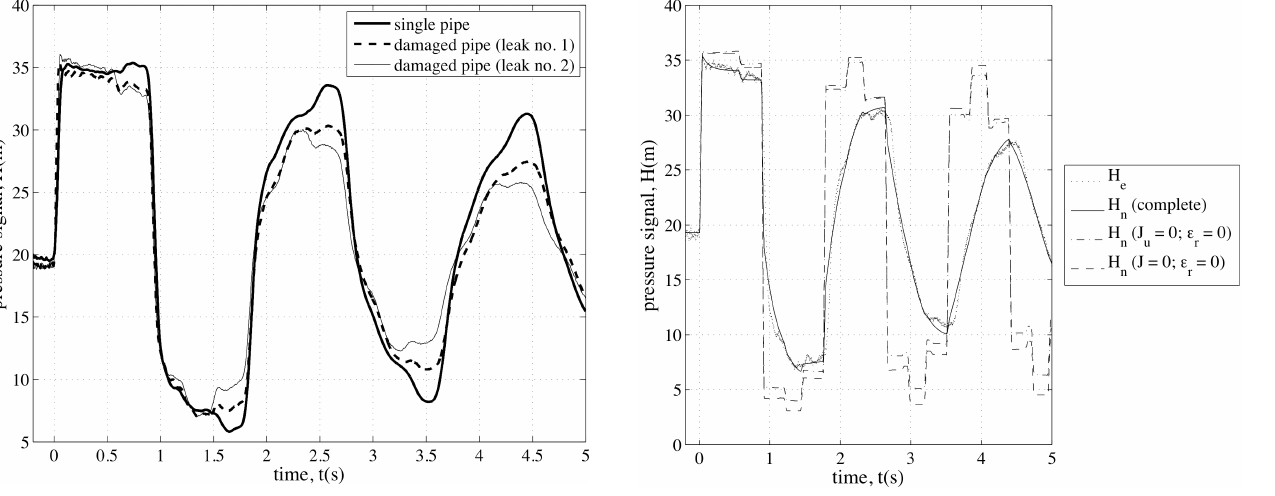
Figure 6. Pressure signal at section M for approximately the same value of the discharge at the end valve, Q 0 ( ≅ 3 l/s) in the case of: single pipe, damaged pipe with leak no. 1 and 2, respectively.